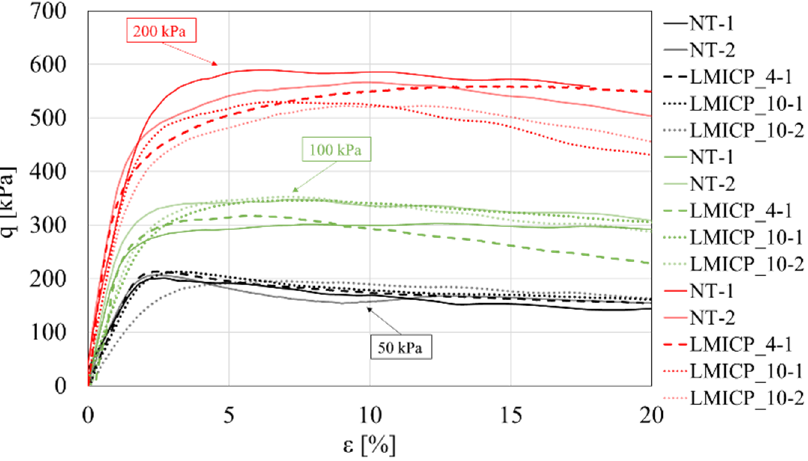
Figure 12. Drained triaxial results on saturated samples of Maicillo treated with LMICP .